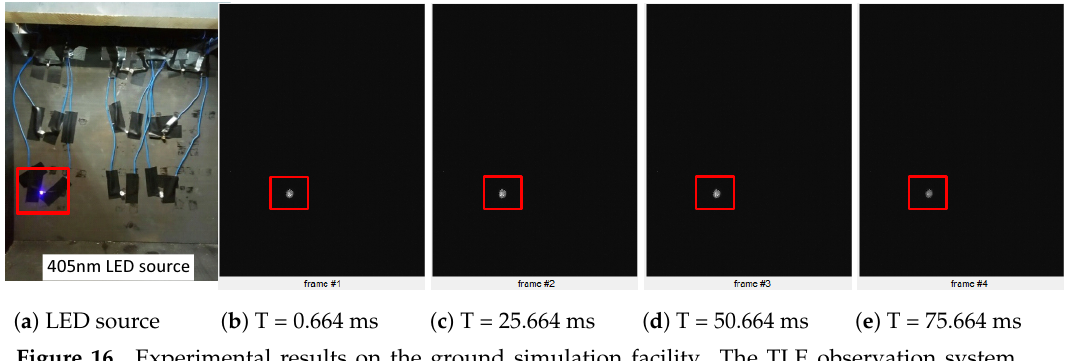
Figure 16. Experimental results on the ground simulation facility. The TLE observation system successfully detected the 405 nm LED flash light which has the duration of 100 ms and obtained four consecutive images of it. The results also show that the camera IP only captured the pixels around the region of interest using the TLE location estimate from the detector